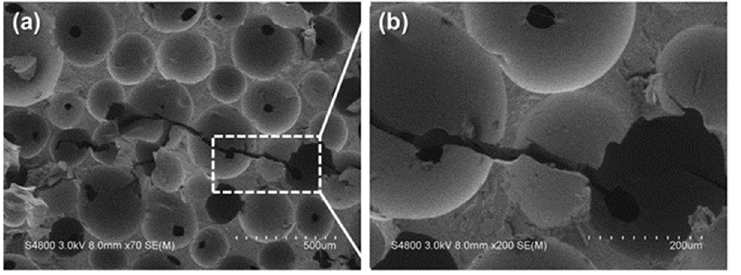
Figure 4. ( a ) Falling weight impact tester, and the corresponding fractured samples of ( b ) PU, ( c ) PU/C, ( d ) PU/C/80 g, and ( e ) PU/C/120 g.